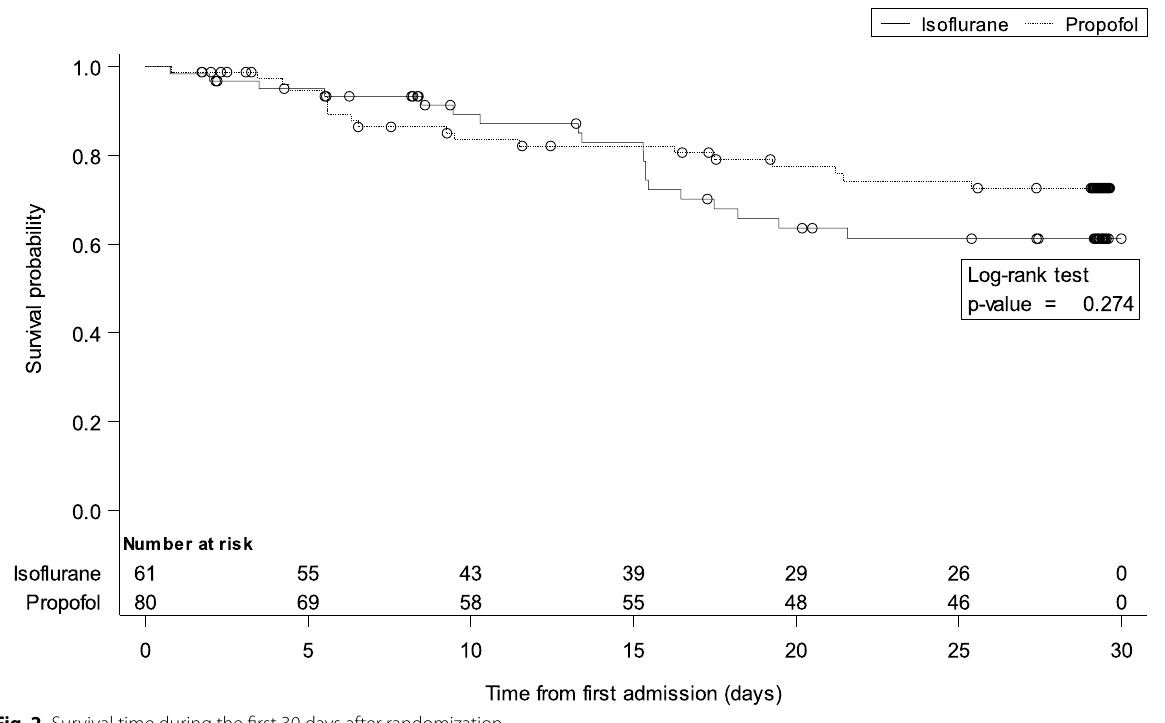
Fig. 2 Survival time during the first 30 days after randomization